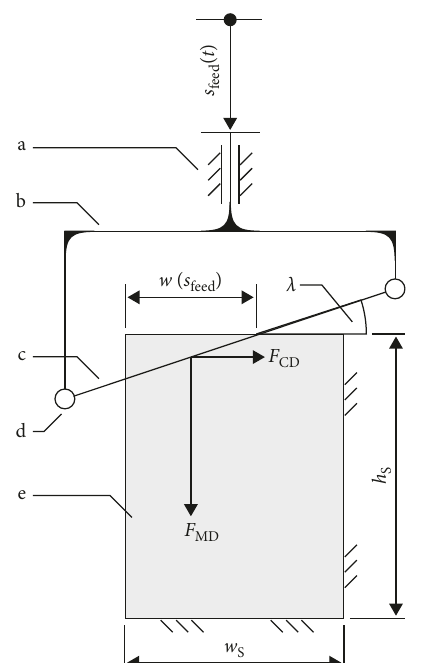
Figure 1: Schematic sketch of the cutting test. (a) Uniaxial guidance. (b) Framework for tensioning the wire. (c) Wire. (d) Wire clamping. (e) Specimen. Feed rate as a function of time s feed ( t ). Height h S and width w of the sample. Cutting width w as a S function of the feed s feed . Oblique angle λ . The force in feed di- rection F MD and the force in orthogonal cross direction F CD . Figure 3: Design of the experimental unit. (a) Load cell HP 011562. (b) Bending beams YCZ-133. (c) Frame. (d) Wire fastening po- sition λ � 45 ° . (e) Wire fastening position λ � 30 ° . (f) Wire fastening position λ � 0 ° . (g) Specimen. (h) Countersupport of the sample.